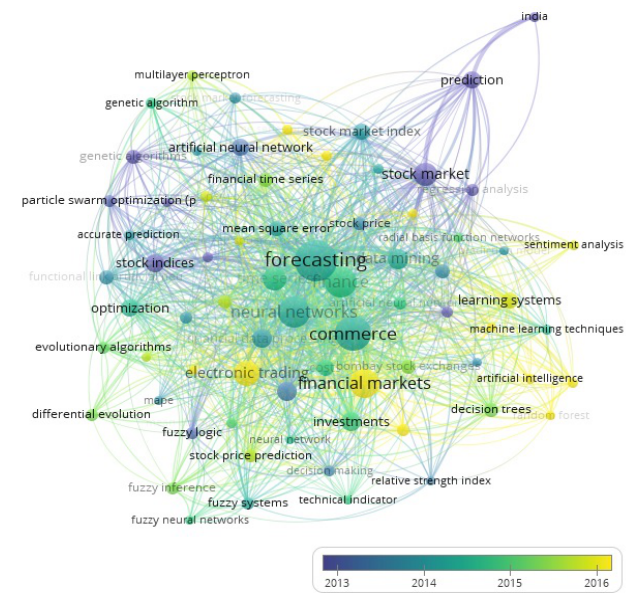
Fig. 6. Keyword analysis (source: VOSViewer).